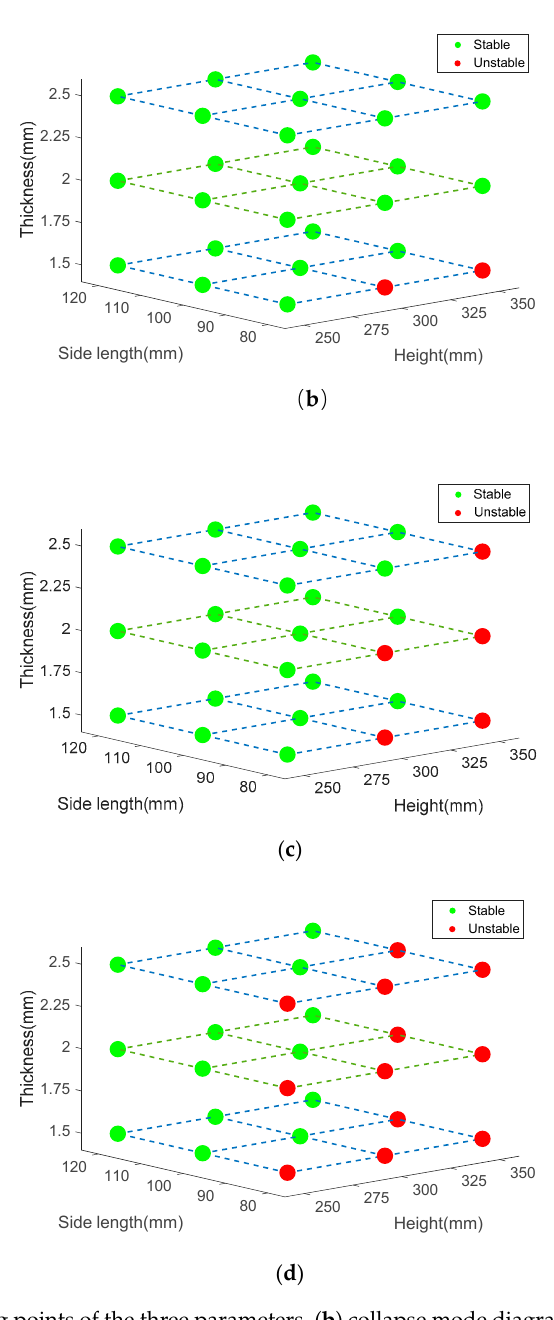
Figure 10. ( a ) Sampling points of the three parameters, ( b ) collapse mode diagram of 0th-order column, ( c ) collapse mode diagram of 1st-order column, ( d ) collapse mode diagram of 2nd-order column.